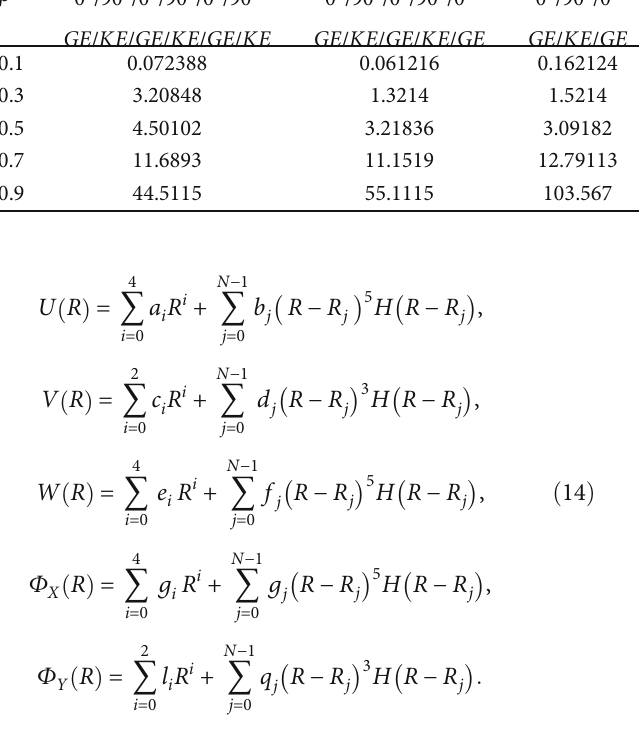
Table 2: Variation of fundamental angular frequency ω with respect to radius ratio β of 6-layered, 5-layered, and 3-layered annular circular plates for n = 4 , n = 2 , and γ = 0 : 05 under simply supported boundary conditions. n = 4 n = 2 β